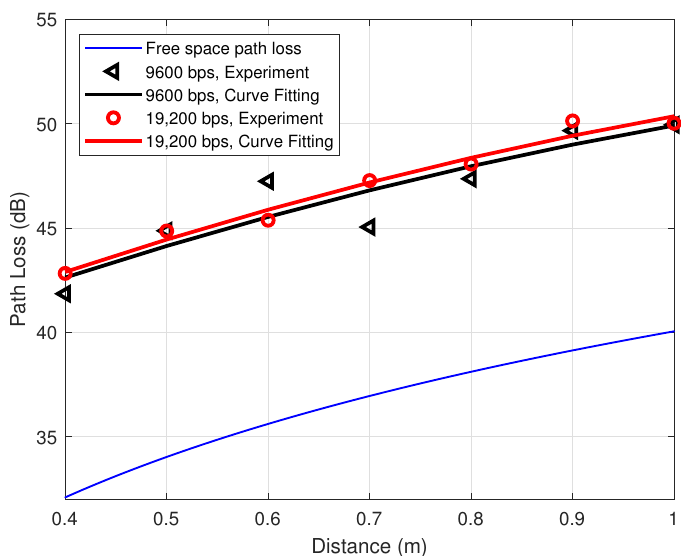
Figure 8. Off-body path loss for different data rates at transmitted power P 0 = 0 dBm.